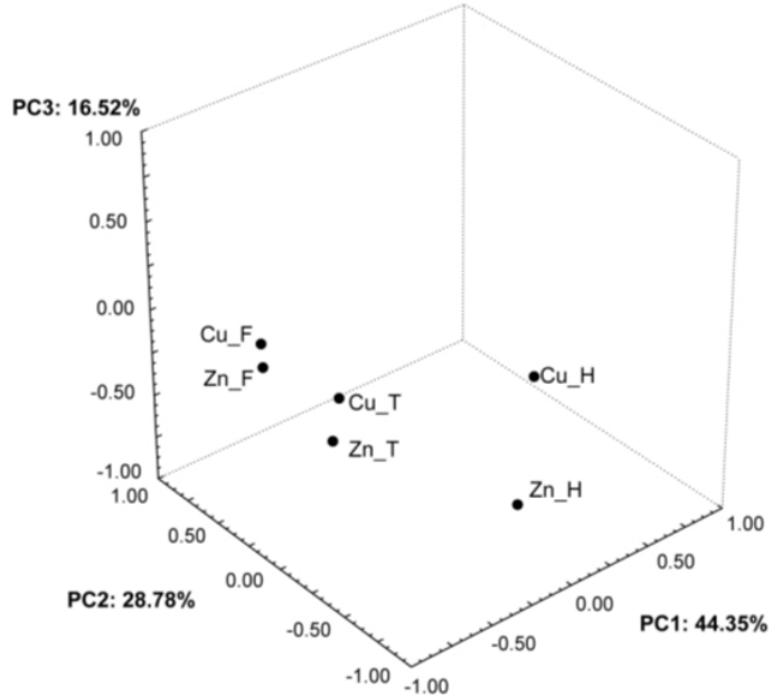
Figure 2. Projection of variables (Cu and Zn) on the space of PC1 (44.35%), PC2 (28.76%) and PC3 (16.52%) principal